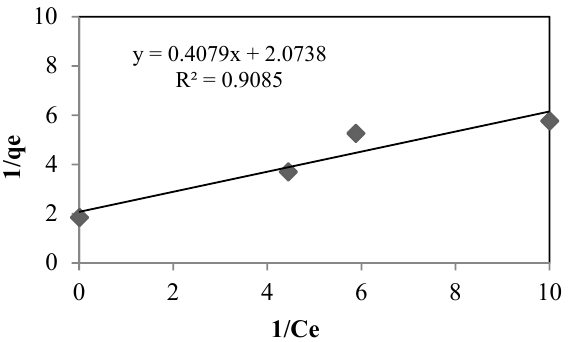
Figure 8. Langmuir (II) isotherm for goethite. As initial : 0.360 mg·L − 1 . T: 22 °C. Table 6. Langmuir (II) isotherm constants. Units Silica Sand Coated with Fe (III)